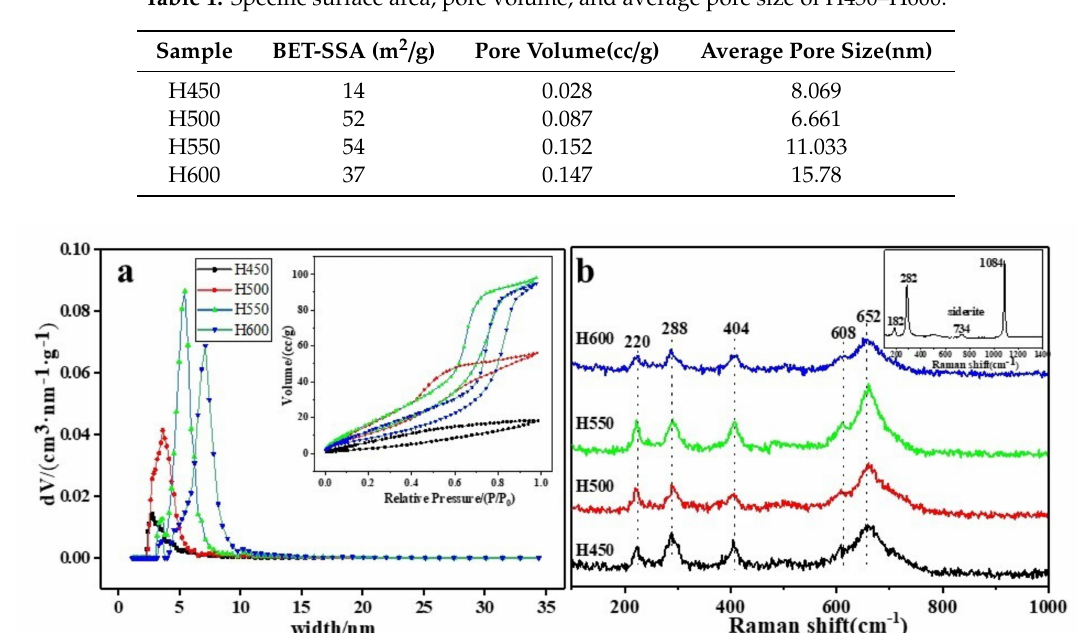
Table 1. Specific surface area, pore volume, and average pore size of H450–H600.